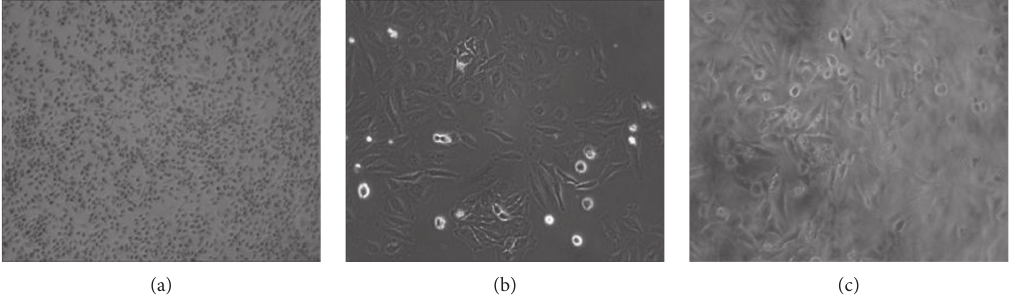
Figure 3: Microscopic images of different stages of HeLa cell proliferation. (a) Confluent HeLa cells; (b) cells grown in a single well; (c) cells after treatment with the extract. Culture condition: cells were cultured in the EMEM at 37 ° C in a 5% CO 2 incubator, observed under an Olympus inverted microscope, VImage 2016-US500 camera type.